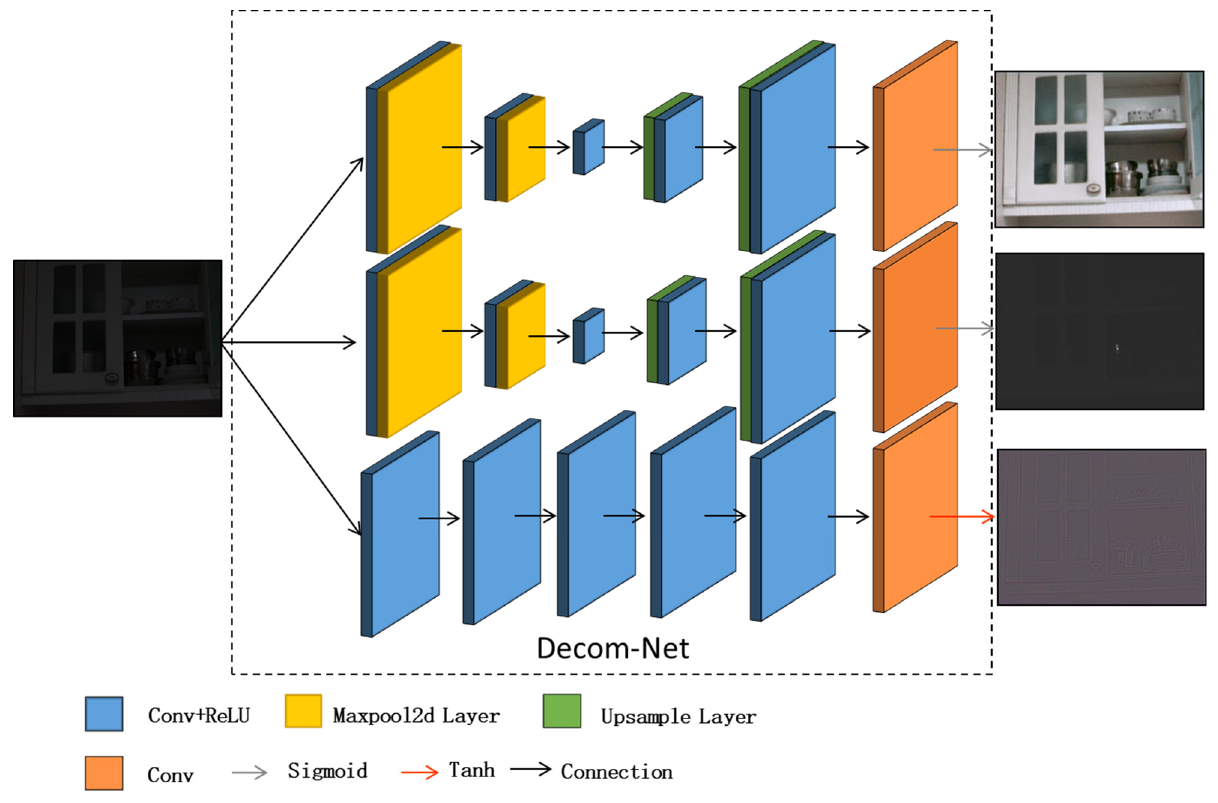
Figure 2. The model structure diagram of the Decom-Net.